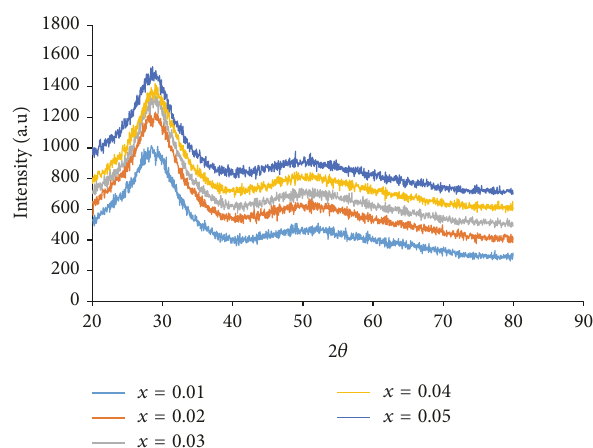
Figure 1: XRD spectra of [(TeO 2 ) 0.70 (ZnO) 0.30 ] (1−𝑥) (Nd 2 O 3 NPs) (𝑥) glasses.